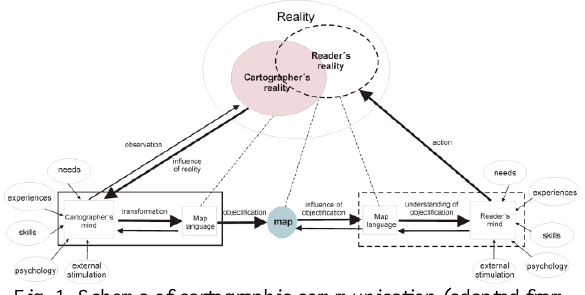
Fig. 1. Schema of cartographic communication (adapted from Kolacny,